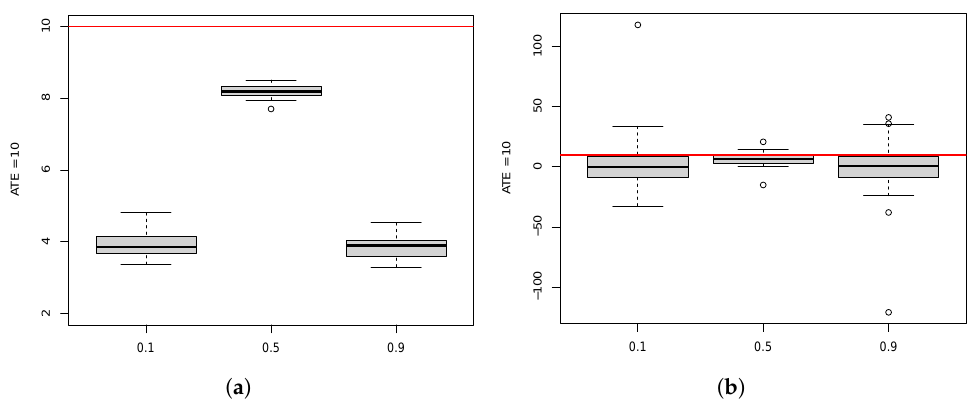
Figure 10. ATE true = 10 estimations for different participation rates for X-Learner RF method. Note that the scales of the two figures are not the same. ( a ) X-Learner RF: linear. ( b ) X-Learner RF: